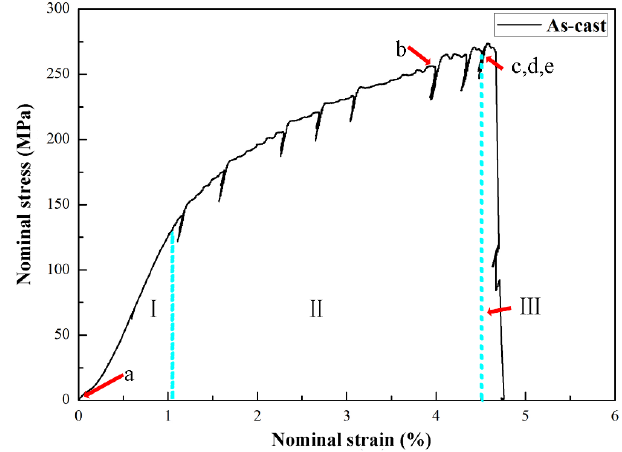
Figure 4. In-situ nominal tensile stress-strain curve of the as-cast alloy.